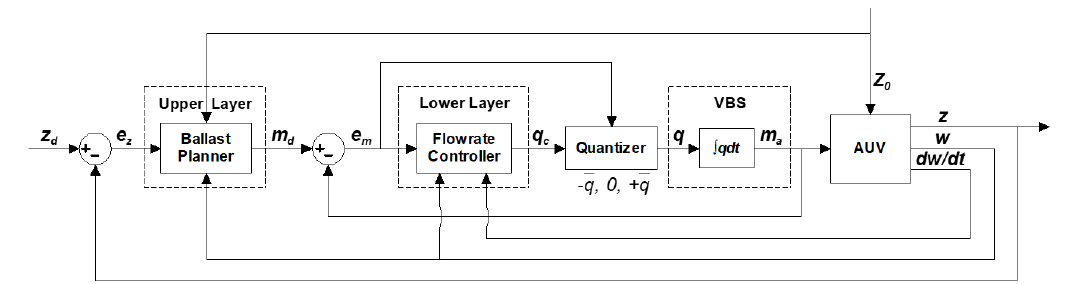
Figure 4. Hierarchical architecture-based control design of the VBS.